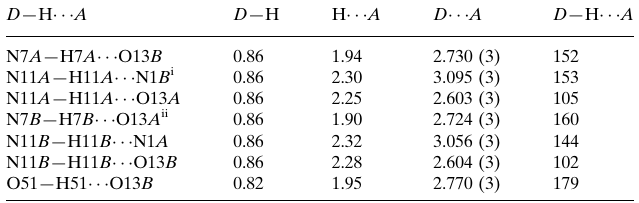
Key indicators: single-crystal X-ray study; T = 293 K; mean (cid:1) (C–C) = 0.005 A ˚ ; disorder in solvent or counterion; R factor = 0.067; wR factor = 0.156; data-to- parameter ratio = 14.1.